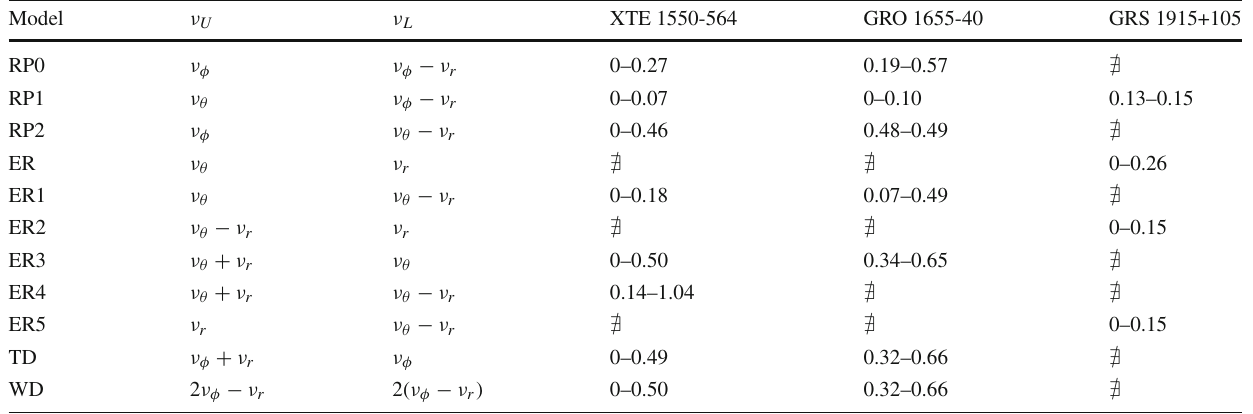
Table 2 Restrictions on the Kerr-MOG BH α parameter given by observed HF QPOs frequencies and BH spin a for all the three micro- quasars GRO 1655-40, XTE 1550-564 and GRS 1915+105. Restriction on Kerr-MOG BH spin a are changing according to Kerr-MOG BH α